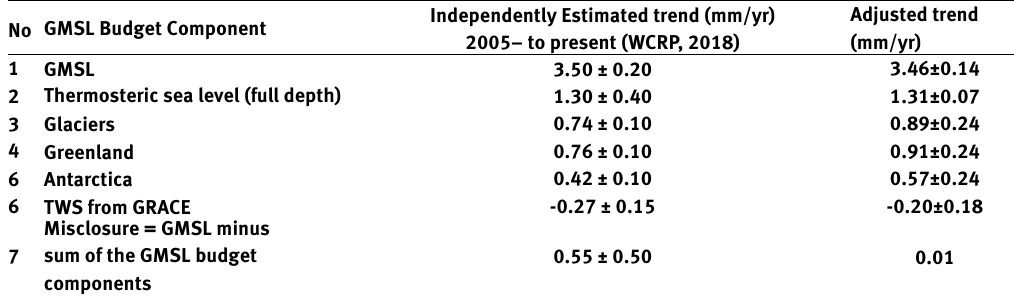
Table 1. Independently estimated and adjusted GMSL budget components. The remaining last digit in the adjusted misclosure, 0.01 mm, is the round-off